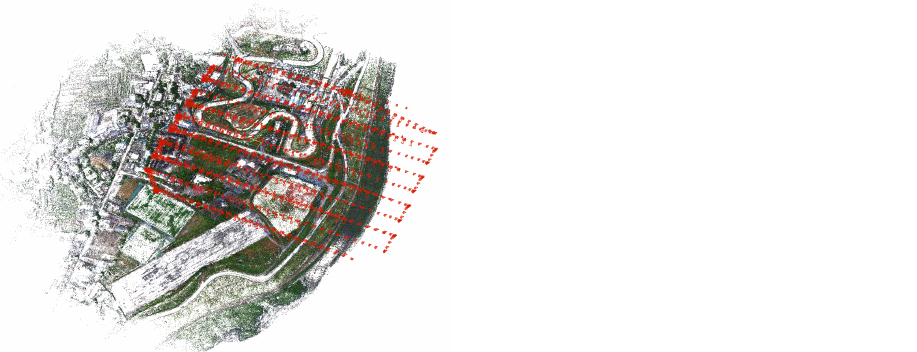
Figure 6. The reconstruction result of one scene in the dataset, where the red markers represent the image shooting